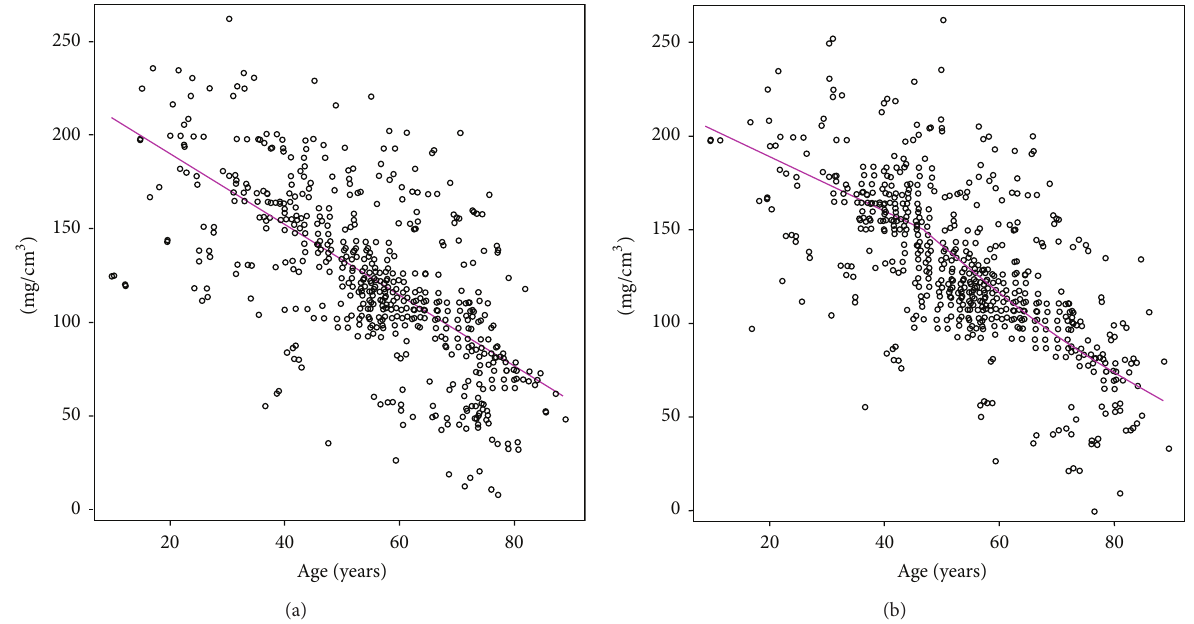
Figure 1: Relationship between age and trabecular vBMD at the third lumbar vertebra for men (a) and women (b) [13].